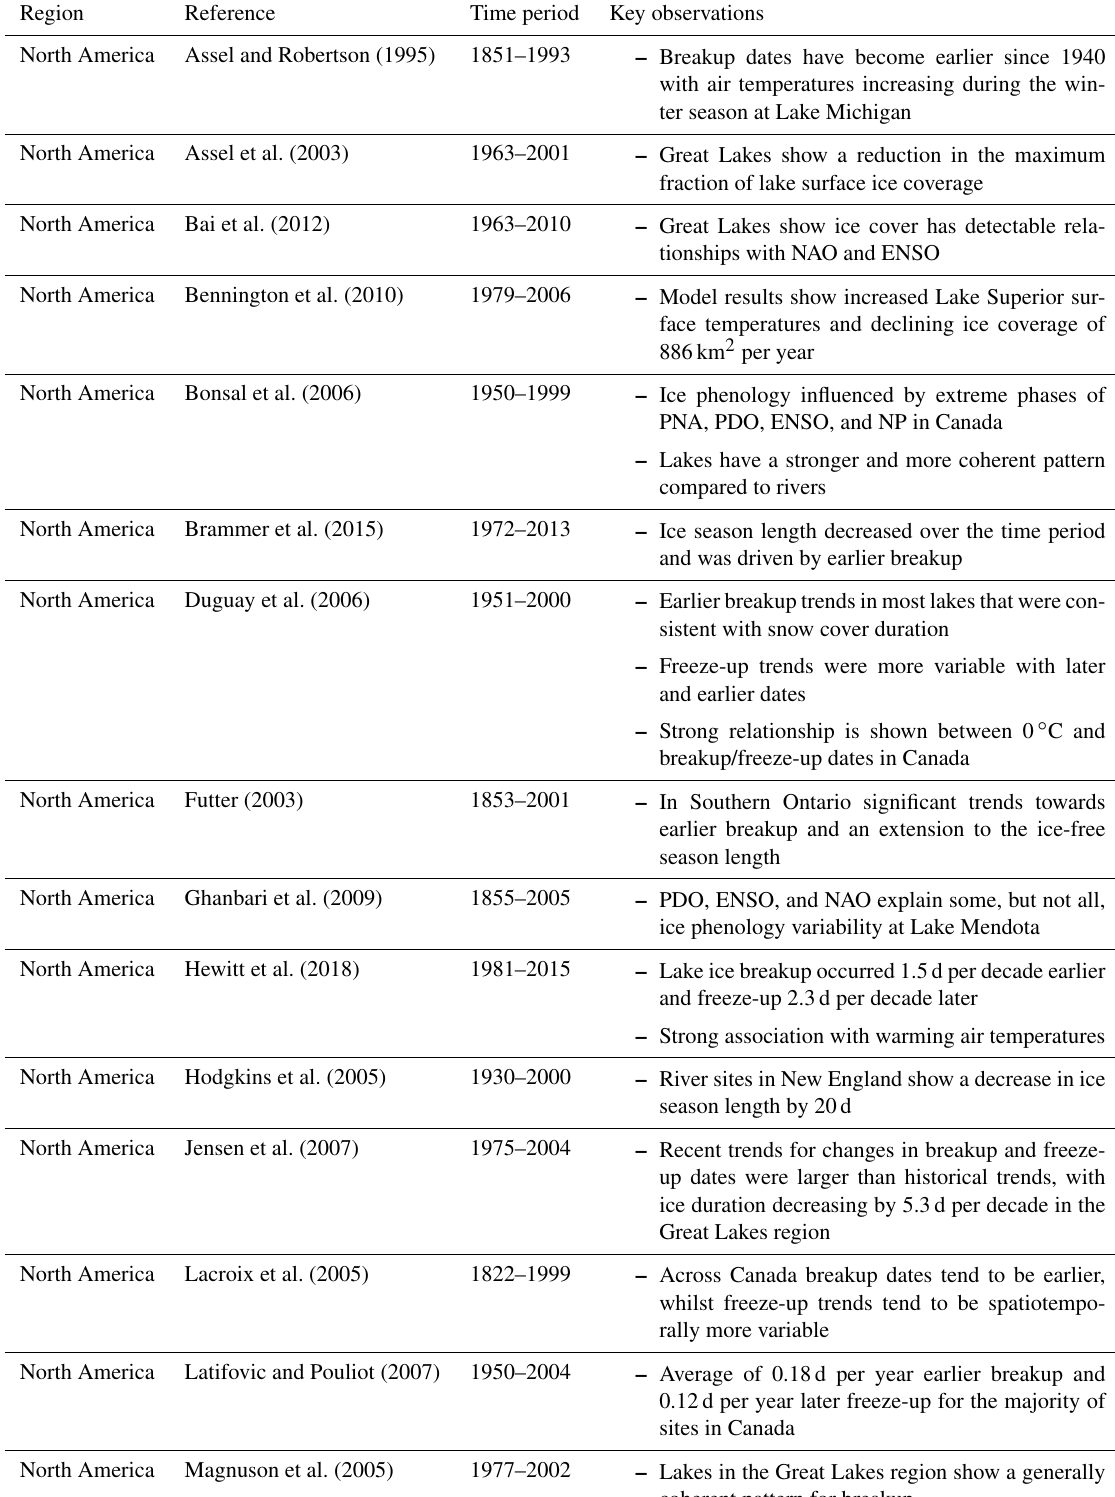
Table 1. Summary of ice phenology trend observations from across the Northern Hemisphere. Note this is not meant to be an exhaustive list, but it provides a general overview of ice phenology